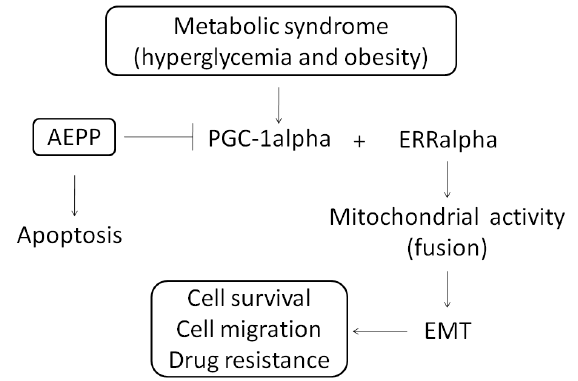
Figure 8. The potential of AEPP against cell proliferation and EMT of OVCAR-3 ovarian carcinoma cells.